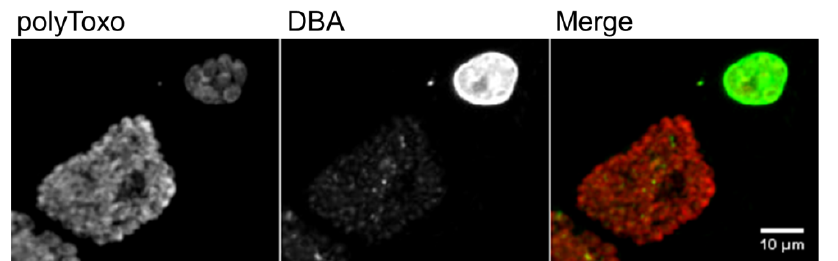
Figure 7. Tachyzoite parasitophorous vacuoles and tissue cysts. Each panel shows tachyzoite parasitophorous vacuoles, stained only with polyclonal antisera against T. gondii surface proteins (polyToxo), and tissue cysts, stained with polyToxo and with Dolichos biflorus agglutinin (DBA) lectin which binds to the tissue cyst wall. The tissue cysts were formed spontaneously in an in vitro culture of T. gondii EGS strain [179,180] invading confluent HFF cells. The scale bar represents 10 µm.